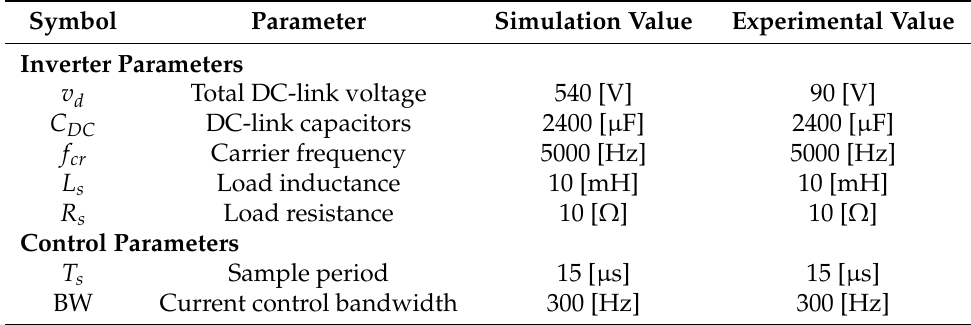
Table 2. Simulation and experimental